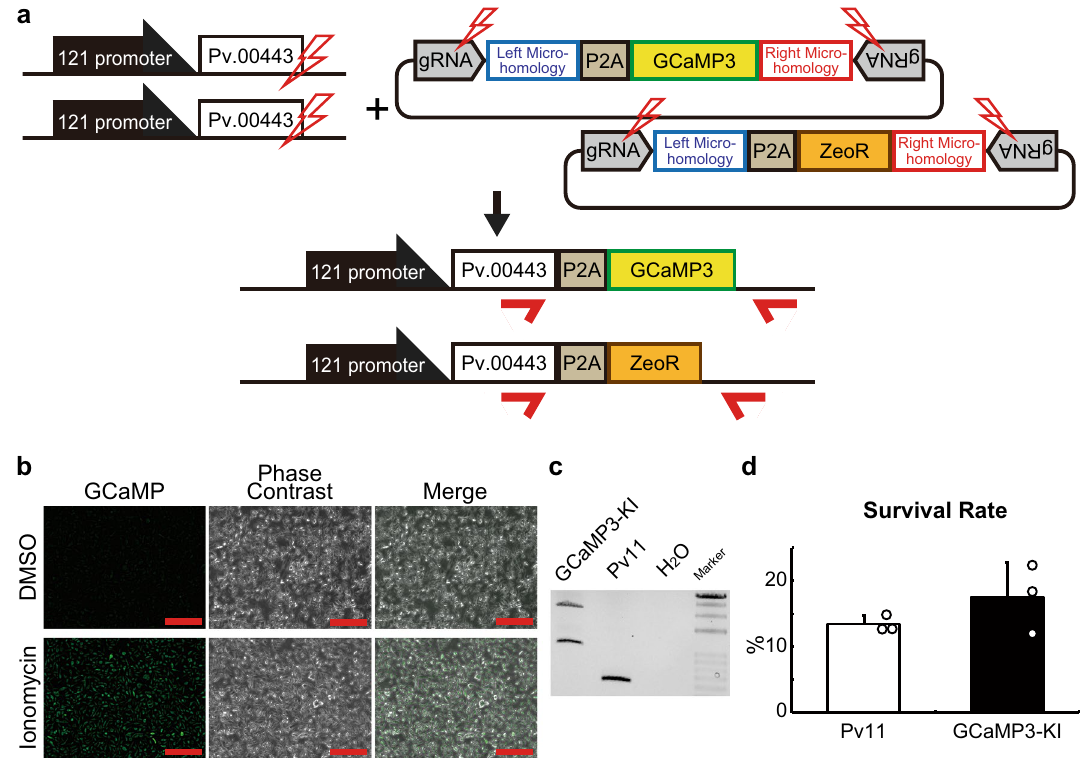
Figure 2. The establishment of a cell line stably expressing GCaMP3. ( a ) The PITCh scheme for GCaMP3 and ZeoR knock-in is shown; Cas9- and gRNA-expression vectors and two donor vectors harboring a gene encoding GCaMP3 or ZeoR were transfected into Pv11 cells. Red arrows indicate the primers used in genomic PCR with gDNA obtained from cells after selection for zeocin resistance and GCaMP3 fluorescence. ( b ) Cell images following treatment with DMSO or ionomycin were acquired by a conventional fluorescence microscope. ( c ) Genomic PCR was carried out on cell DNA (the whole gel image is shown in Supplementary Fig. S6). ( d ) Comparison of survival rate after desiccation-rehydration treatment of Pv11 and GCaMP3-KI cells. Scale bars, 100 µm. Values are expressed as mean ± SD; n = 3 in each